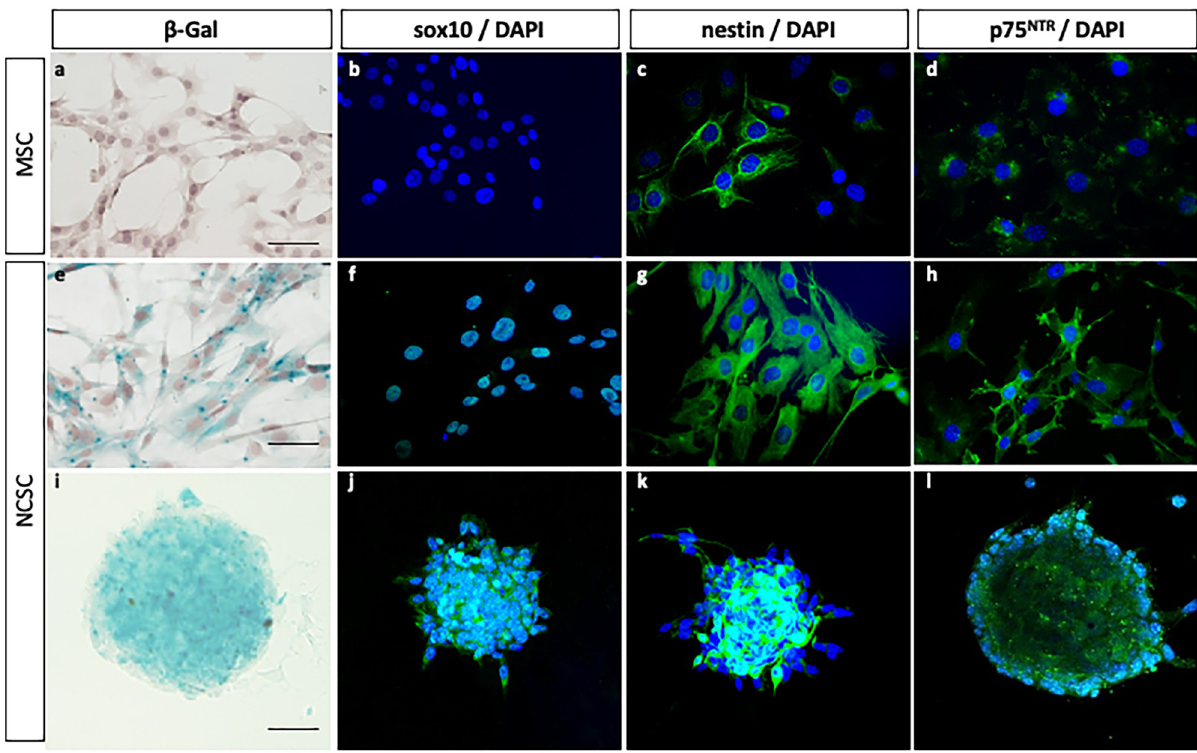
Fig 1. Characteristics of mouse NCSC and MSC from adult bone marrow. NCSC obtained from Wnt1-Cre/R26R-LacZ mice expressing LacZ . In adherent culture conditions, MSC did not express β -galactosidase (a) neither sox10 (b), but a small and constant proportion of cells slightly expressed nestin (c) and p75 NTR (d). NCSC expressed β -galactosidase (e), sox10 (f), Nestin (g) and p75 NTR (h). Finally, among these two populations, only NCSC were able to grow as spheres; spheres also express β -galactosidase (i), Sox10 (j), Nestin (k) and p75 NTR (l). (Scale bars = 40 μ m).